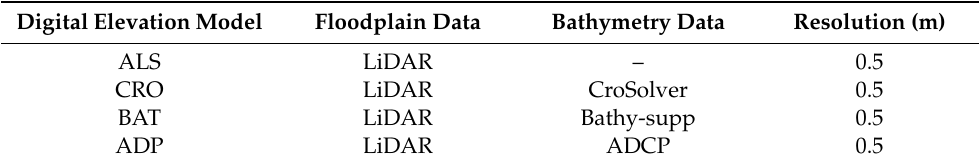
Table 4. Overview of compared digital elevation models